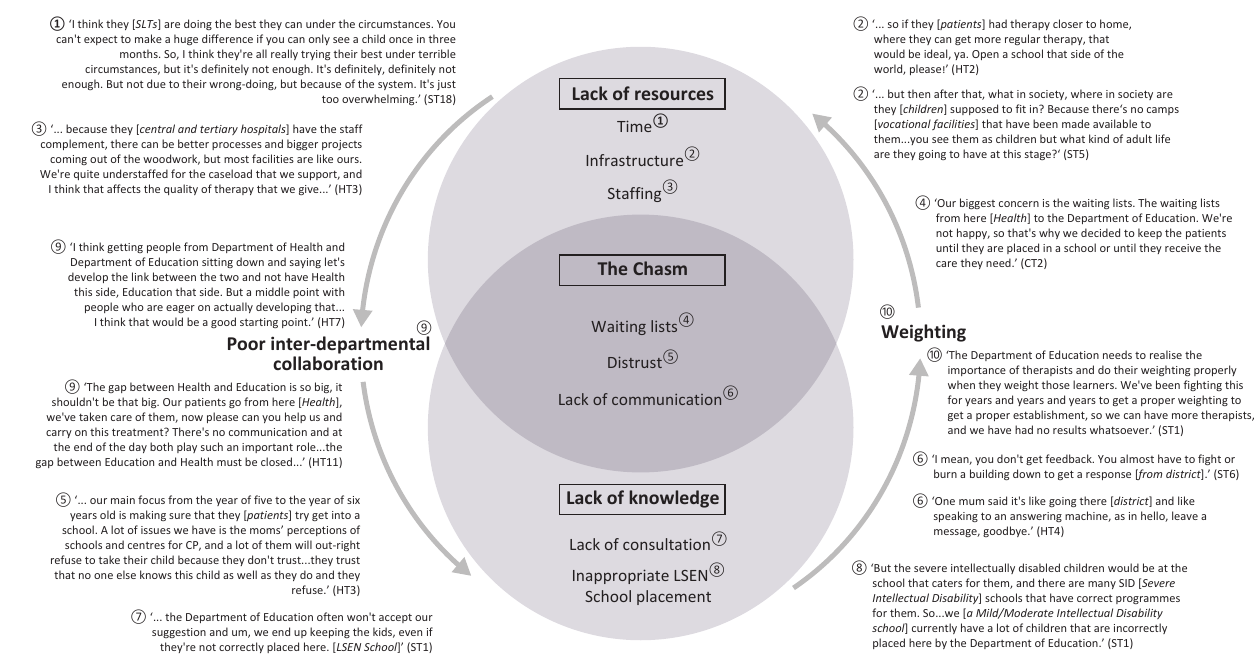
FIGURE 2 : Visual representation of research data obtained through thematic